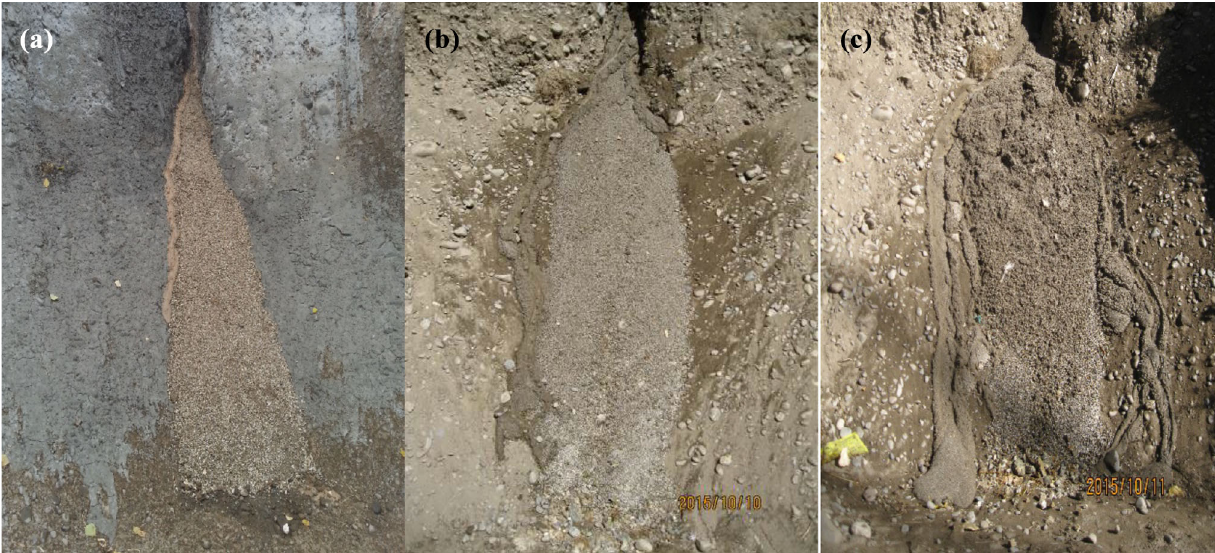
Fig. 5 Images of water–sand flow initiation under different rainfall intensity: light rainfall ( a ), moderate rainfall ( b ), and heavy rainfall ( c )